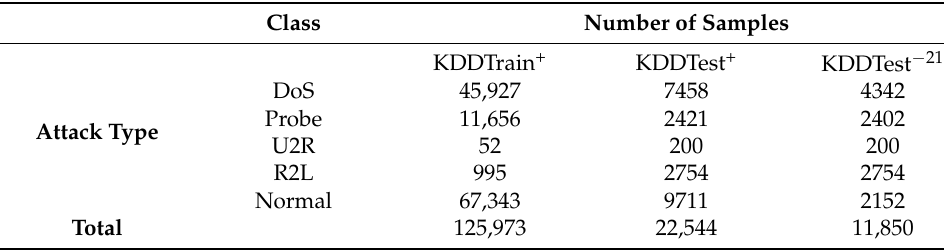
Table 1. Traffic sample breakdown of the NSL-KDD